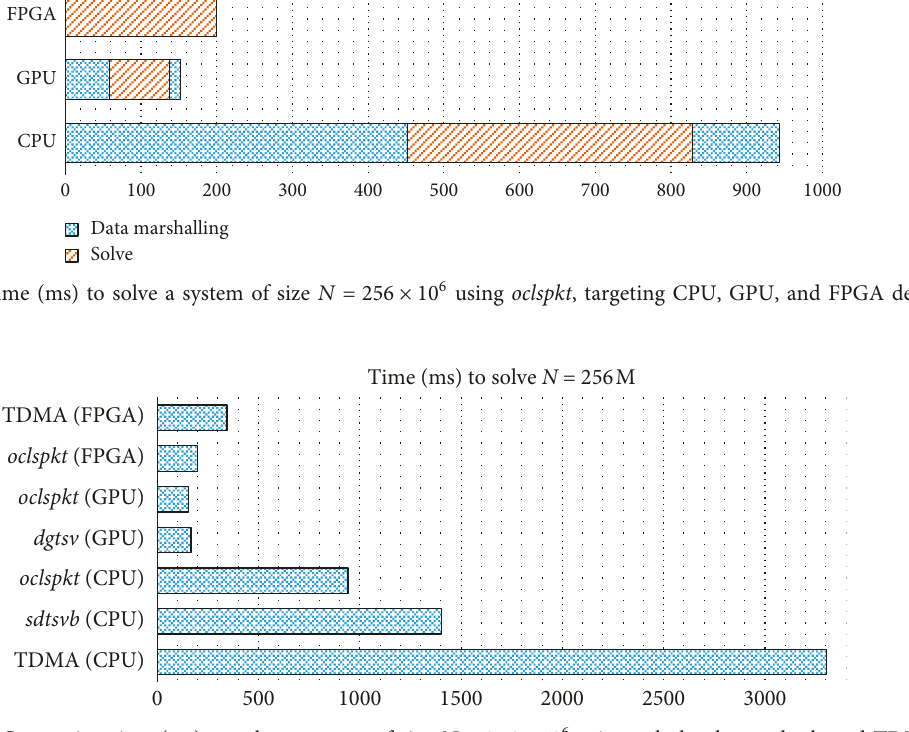
Figure 7: Comparing time (ms) to solve a system of size N � 256 × 10 6 using oclspkt , dgtsv , sdtsvb , and TDMA.